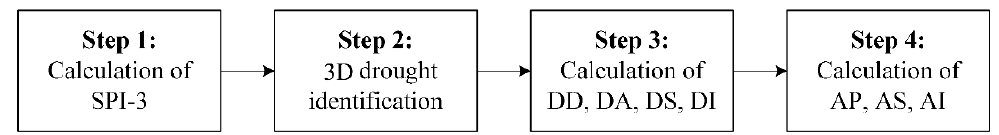
Figure 2. Framework of the methodology used in this study.